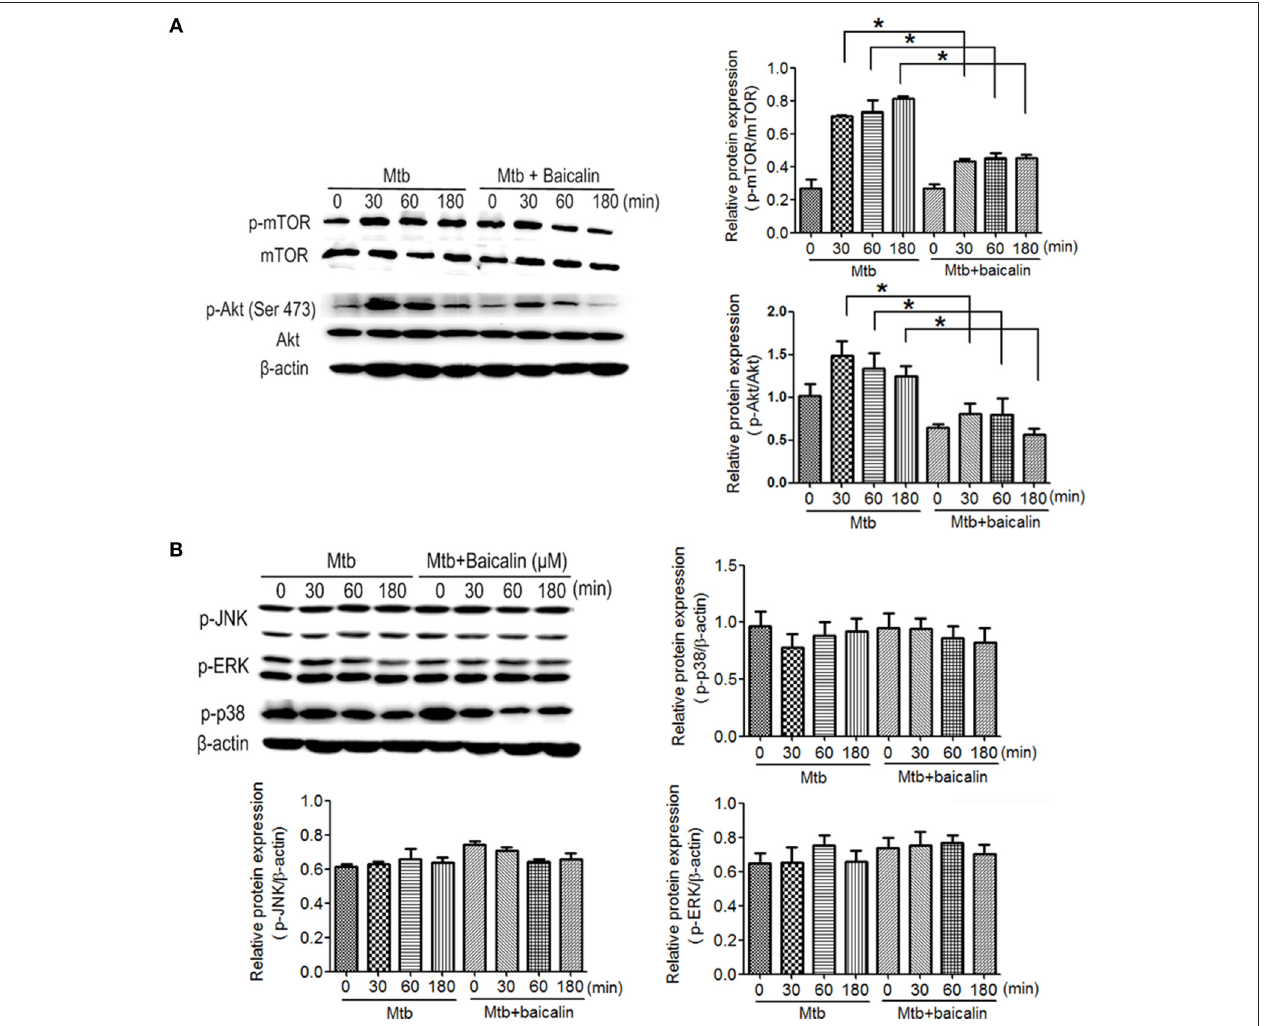
FIGURE 7 | Bacalin suppresses the PI3K/Akt/mTOR pathway but has no effect on the MAPK signaling in Raw264.7 cells. (A) Western blot analysis of mTOR, p-mTOR, Akt, and p-Akt expression in Raw264.7 cells. β -actin was used as a control. The right bar graphs show the statistical results for the relative quantitative expression of p-Akt and p-mTOR. (B) Western blot analysis of p-JNK, p-ERK, and p-p38 expression in Raw264.7 cells. The right and below bar graphs show the statistical results for the relative quantitative expression of p-p38, p-ERK, and p-JNK. Data are shown with the means ± SD of at least three independent experiments. * p <